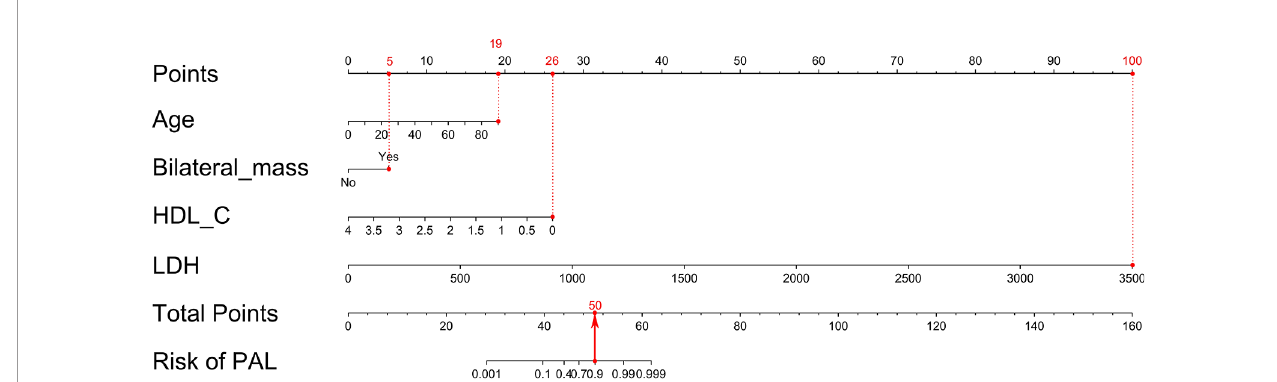
FIGURE 2 | Nomogram to predict PAL based on age, bilateral masses, HDL-C and LDH. To build the nomogram, the fi rst step was to locate each statistically signi fi cant variable (including age, bilateral masses, HDL-C and LDH) on the relevant axis, and then a straight line was drawn upward to the point axis on the top to gain the points for each predictor. The second step was to sum all points gained from each predictor to calculate the total points and locate them on the total point axis. Finally, a straight line was drawn at the bottom to indicate the probability of developing PAL. HDL-C, high-density lipoprotein cholesterol; LDH, serum lactate dehydrogenase; PAL, primary adrenal lymphoma.